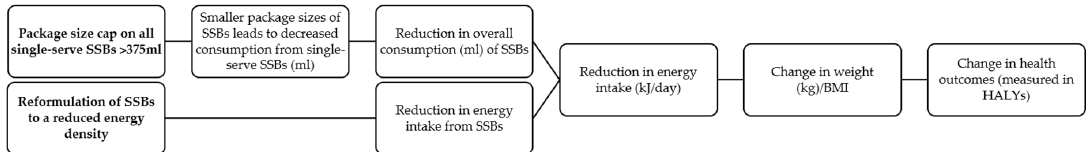
Figure 1. Logic pathway for modelling the effect of the SSB package size cap and reformulation of SSBs to a reduced energy density interventions for obesity prevention. HALYs: health-adjusted life years; BMI: body mass index; SSBs: sugar-sweetened beverages.